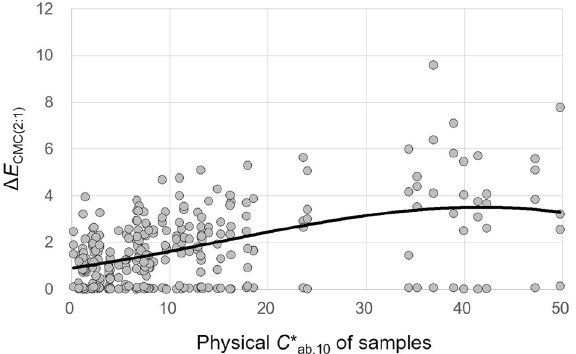
Figure 16. Effect of the physical C * ab,10 of samples on their overall color appearance change, Δ E CMC(2:1) , under illuminants.